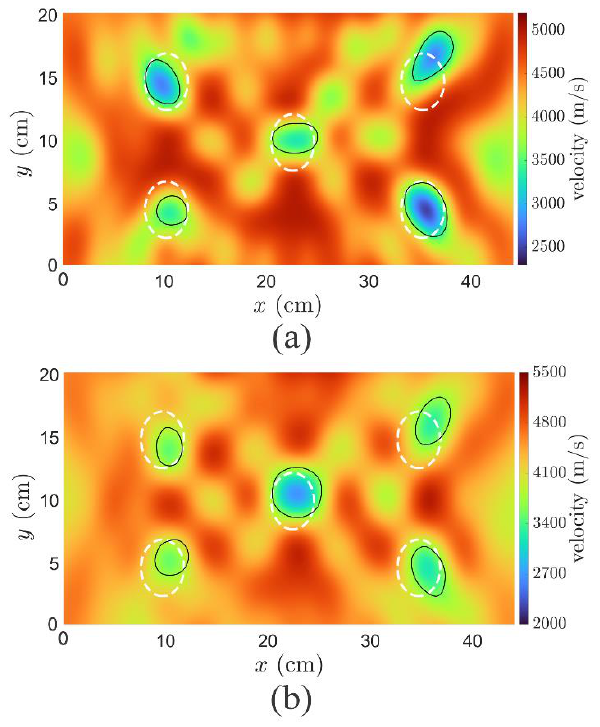
Figure 11. Tomographic results for ( a ) TDAT and ( b ) FAAT. The black solid lines delineate the identified anomalous areas, and the white dotted lines delineate the original anomalous areas.